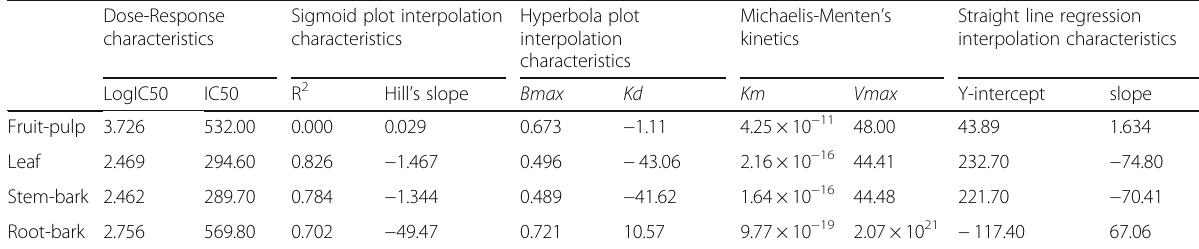
Table 2 Dose-enzyme response characteristics of the influence of Annona muricata methanolic extracts on tissue amylase activity Dose-Response